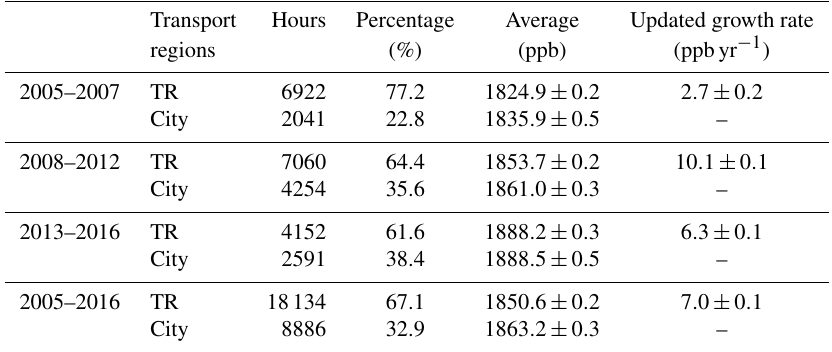
Table 5. The statistics of CH 4 data without air mass transport regions (TRs) from cities over different periods during 2005–2016 at the WLG